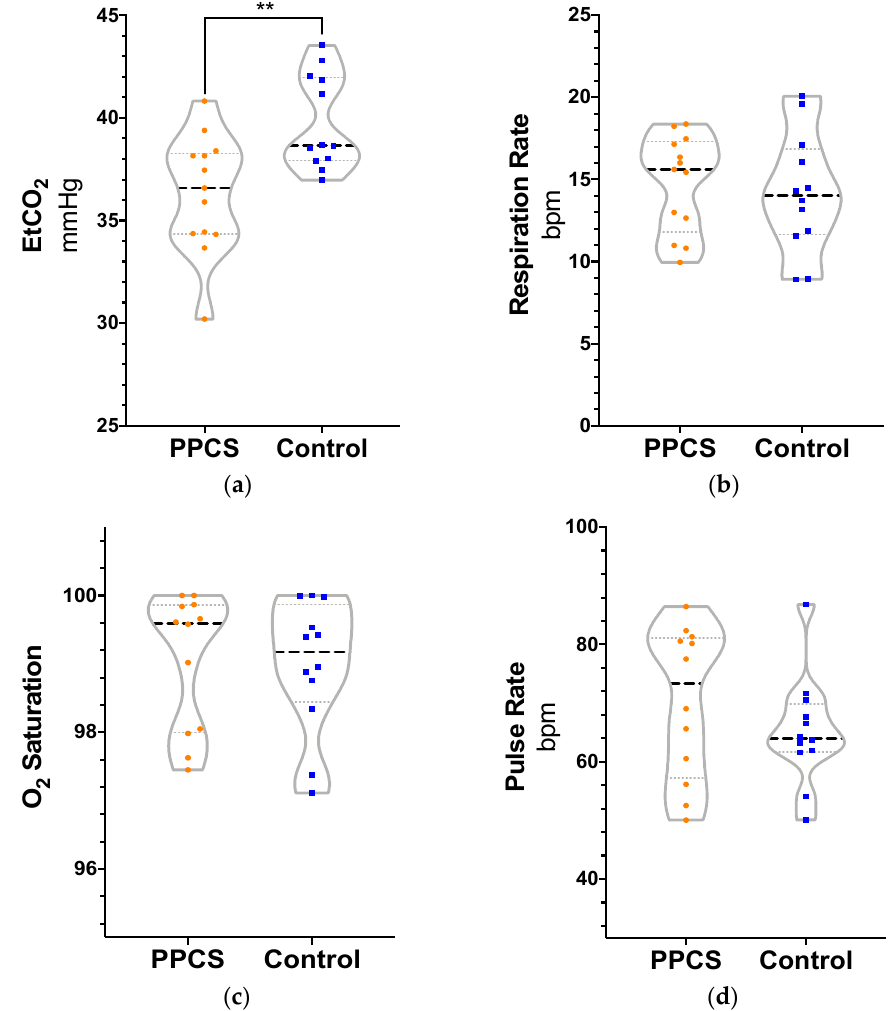
Figure 1. Truncated violin graphs for cardiorespiratory variables by group. ( a ) EtCO 2 ( b ) Respiration rate ( c ) Oxygen saturation ( d ) Pulse rate. The lines represent quartile ranges (gray) and median values (black). bpm = beats per minute (respiration rate) or breaths per minute (pulse rate).